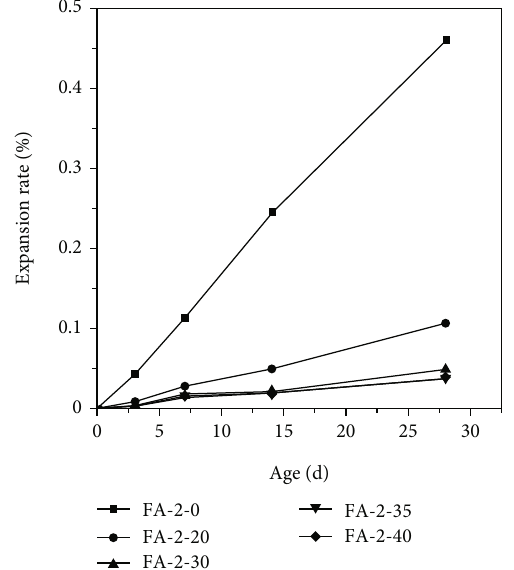
Figure 10: Graph of the expansion rate of the specimen and the amount of coal ash content (cement alkali content 0.90%).